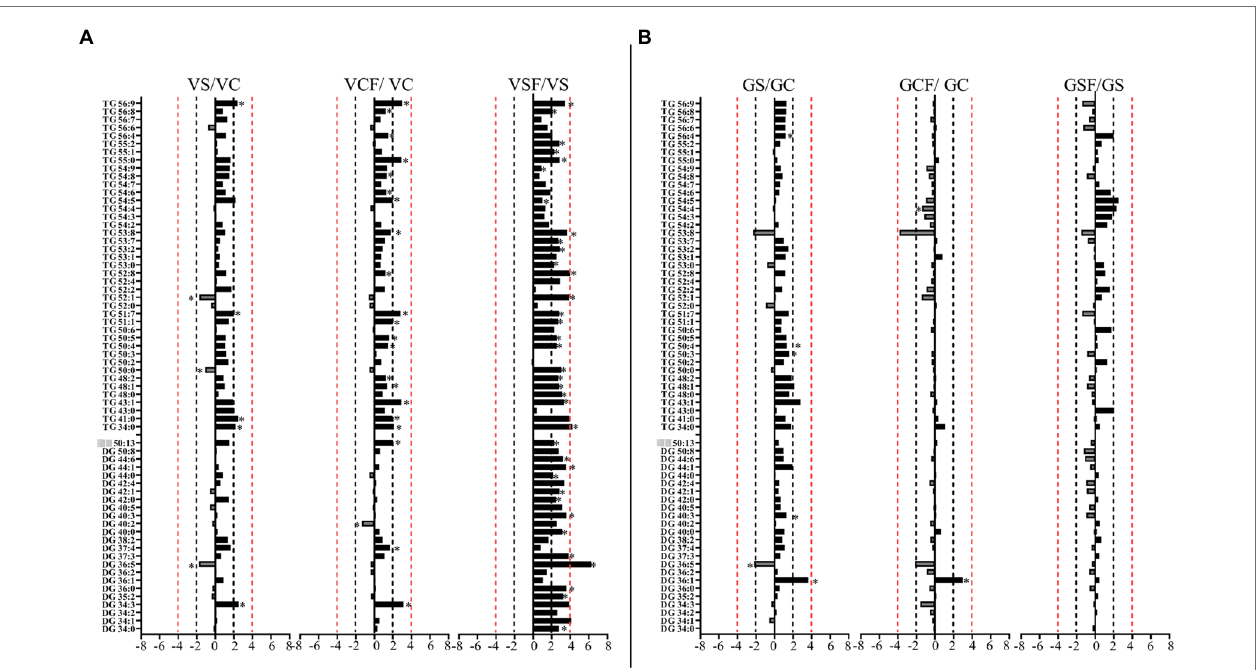
FIGURE 9 | Logarithmic ratios of representative diacylglycerol (DG) and triacylglycerol (TG) content in roots of barley cv. Vlamingh (V) given as (A) and cv. Gairdner (G) given as (B) , showing three comparisons—salt grown (200 mM NaCl) vs. control grown ( VS /VC and GS/GC); control with fungus vs. control grown (VCF/VC and GCF/GC); salt and fungus grown vs. salt grown (VSF/ VS and GSF/GS). An asterisk ( * ) indicates that the values are significantly different ( p < 0.05, FDR). A black dashed line indicates a 2-fold change threshold, whereas a red dashed line indicates a 4-fold change threshold. All treatments included a total of six replicates ( n =